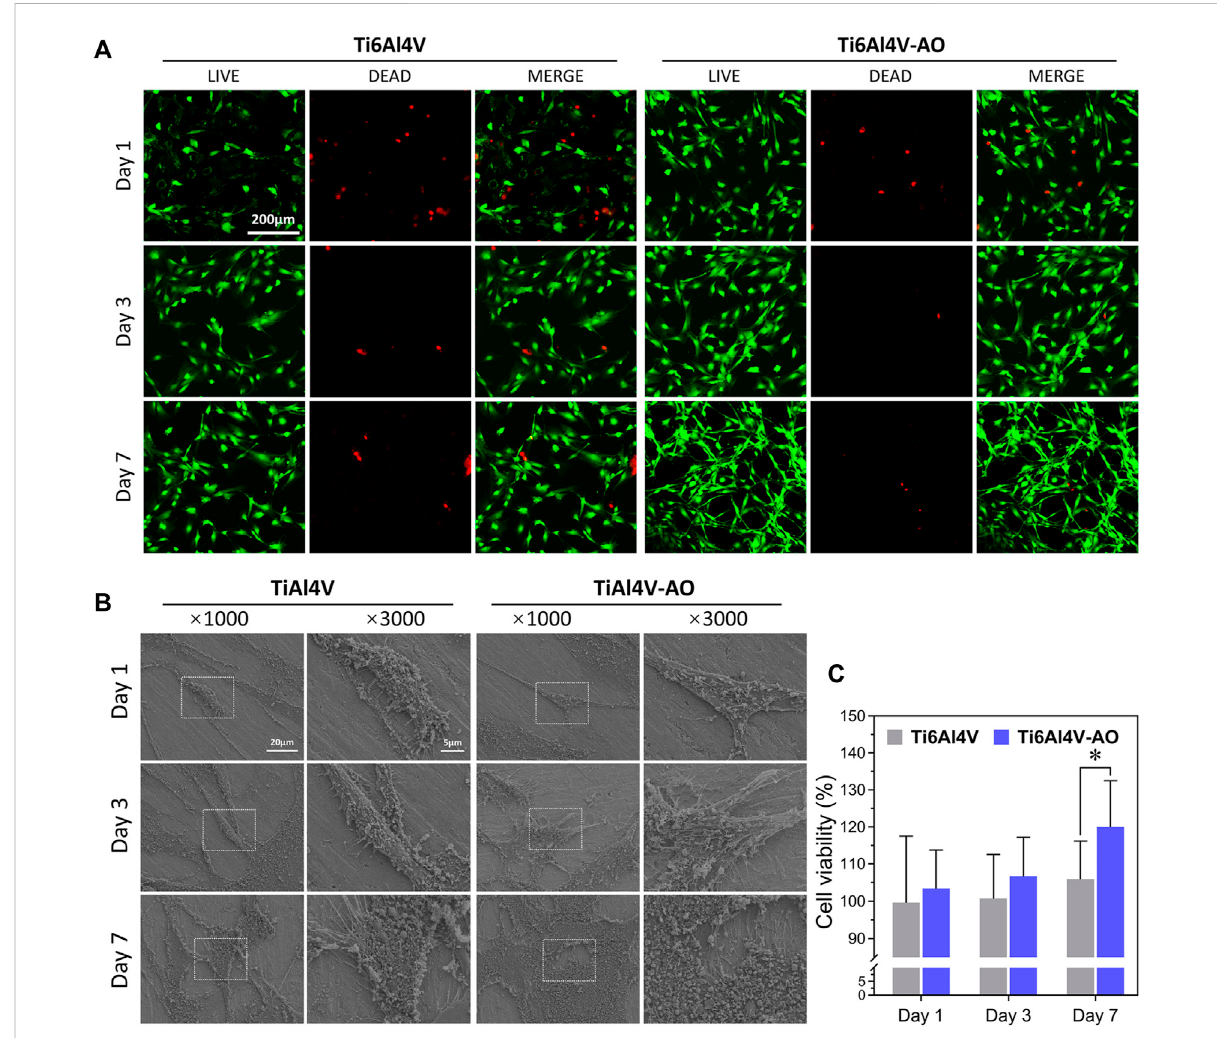
FIGURE 2 Biocompatibility detection of CSDP in vitro . (A) LIVE/DEAD cell viability observation. The cell viability of MC3T3-E1 cells co-cultured with Ti6Al4V-AO and Ti6Al4V for 1, 3, and 7 days. (B) Cell adhesion morphology scanning electron microscopy observation. The adhesive cell morphology of MC3T3-E1 cells co-cultured with Ti6Al4V-AO and Ti6Al4V for 1, 3, and 7 days. (C) CCK-8 cell proliferation rate detection. The proliferation rate of MC3T3-E1 cells co-cultured with Ti6Al4V-AO and Ti6Al4V for 1, 3, and 7 days. ( n = 4). * p <